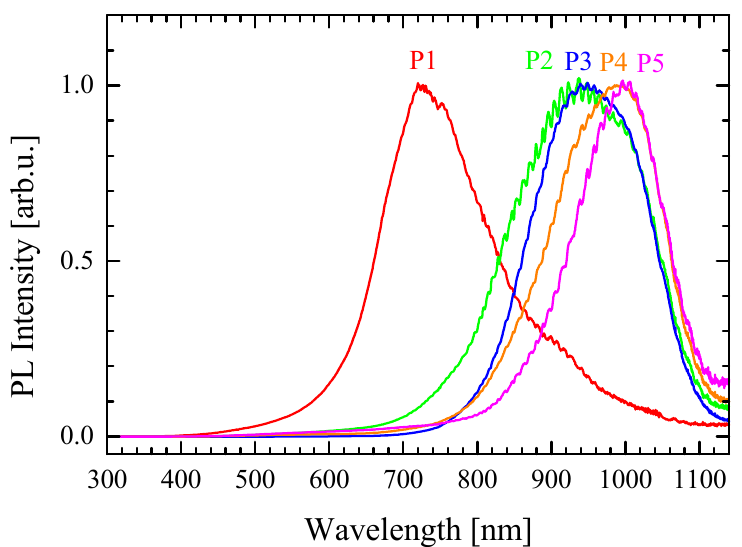
Figure 2. Photoluminescence spectrum of thin films of P1 – P5 and their blends polymer:PC 71 BM (1:2) (red lines).